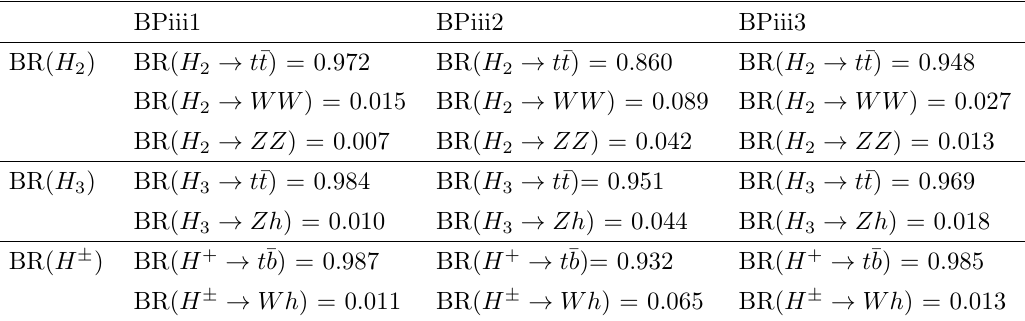
Table 7 . The dominant branching ratios of the BPiii1-3 Higgs